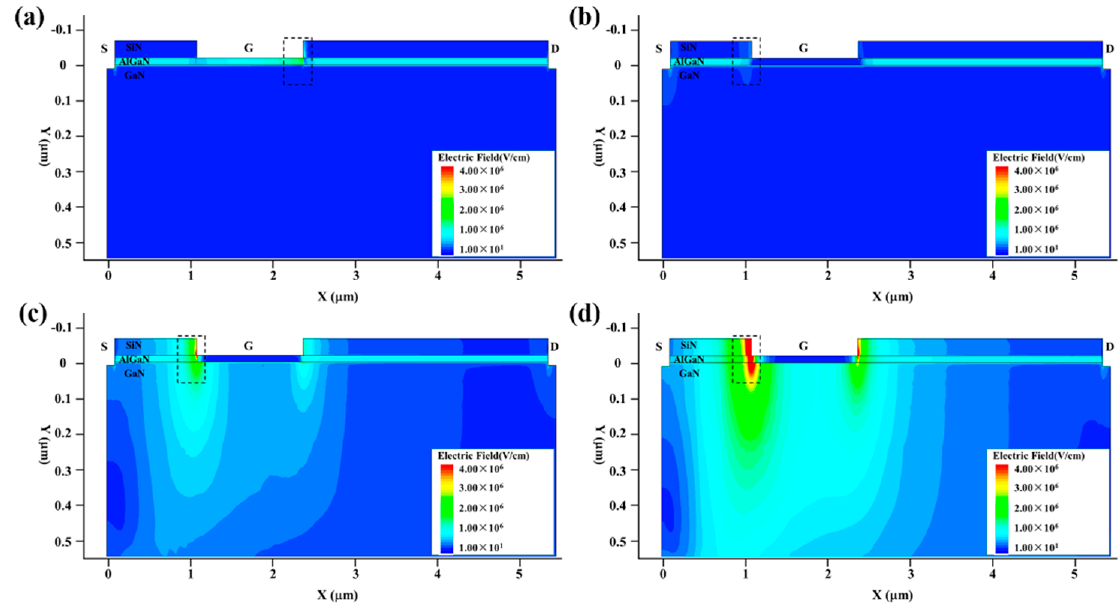
Figure 4. The internal electric field distribution of the device at various injection times: ( a ) 0 ns, ( b ) 0.1 ns, ( c ) 0.5 ns and ( d ) 2 ns.